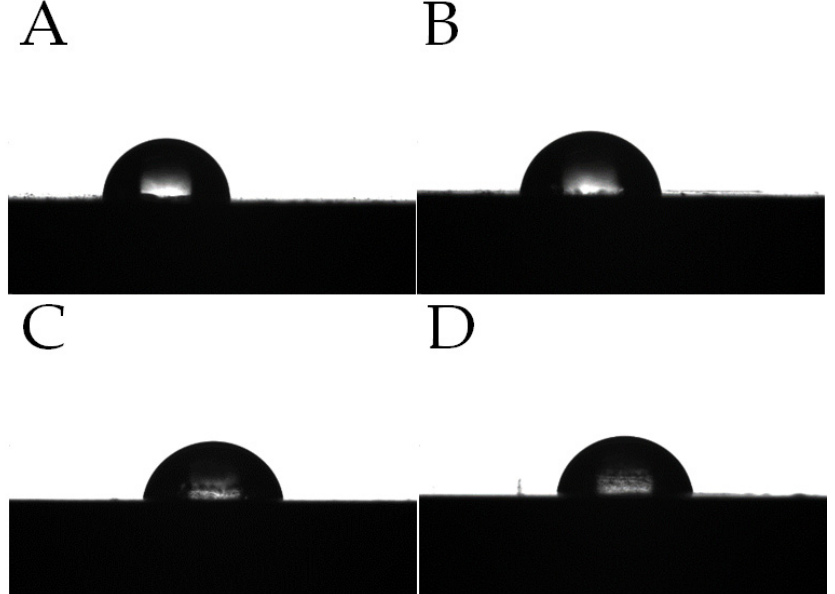
Figure 18. Water droplets at the surface of composites after conditioning at room temperature (RT) and after conditioning in the weathering chamber (WCh): ( A )–15sedA RT, ( B )–15sedB RT, ( C )–15sedA WCh, ( D )–15sedB WCh.